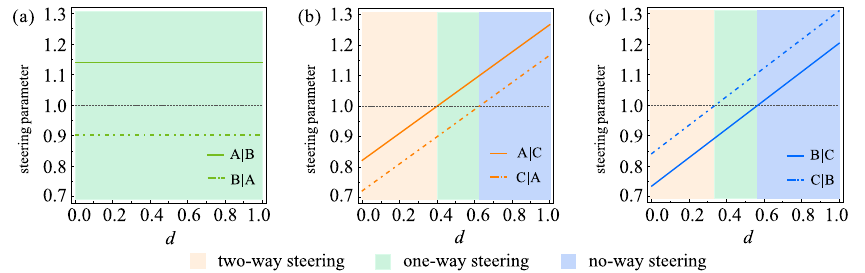
Figure 4. The effects of decoherence channels on the direction of reduced bipartite steering. ( a ) The steerability 1 / √ 3 , θ π/ 6 vs d . ( b ) The steerability of ε(ρ AC ) with r of ε(ρ AB ) with r = = 8 / 9 , θ π/ 6 vs d . Orange, green, and blue regions correspond to two-way steerability of ε(ρ BC ) with r = = steerable, one-way steerable and no-way steerable,